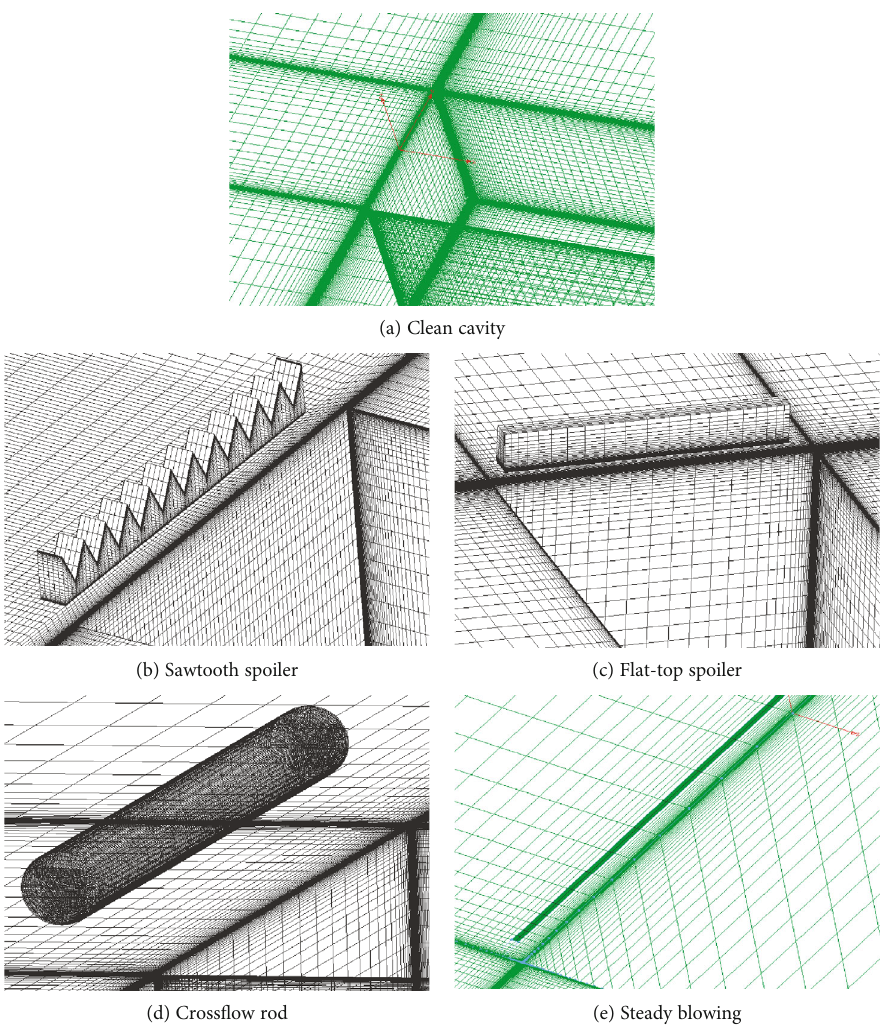
Figure 3: Computational mesh for all